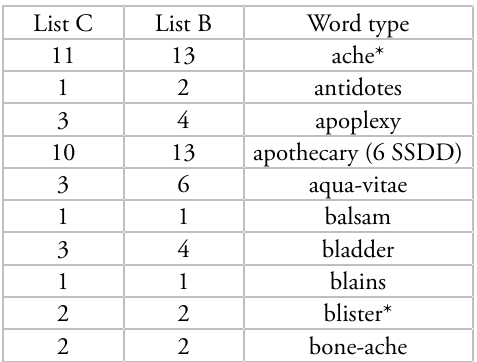
the whole corpus, and other words are present only in the selected plays